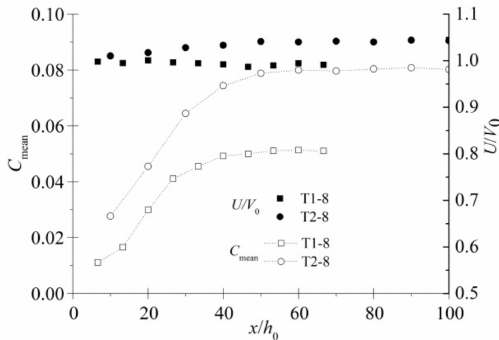
Figure 5. Mean of concentration and velocity along the chute (Run: T1–8).